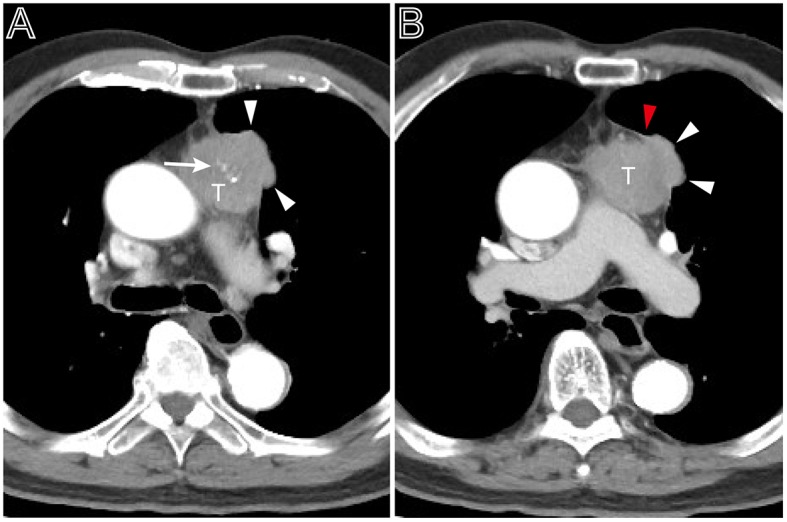
A heterogeneous thymoma accompanied with pleural nodule. (A) Axial contrast-enhanced chest CT image obtained at the level of the pulmonary trunk demonstrated a multi-lobulated thymoma with internal multiple calcification lesions (white arrow) in a 69-year-old man with myasthenia gravis (Masaoka–Koga stage IVa and WHO classification B3). (B) Showed the adjacent thickened pleura (red arrow head) and pleural nodule (white arrow head).